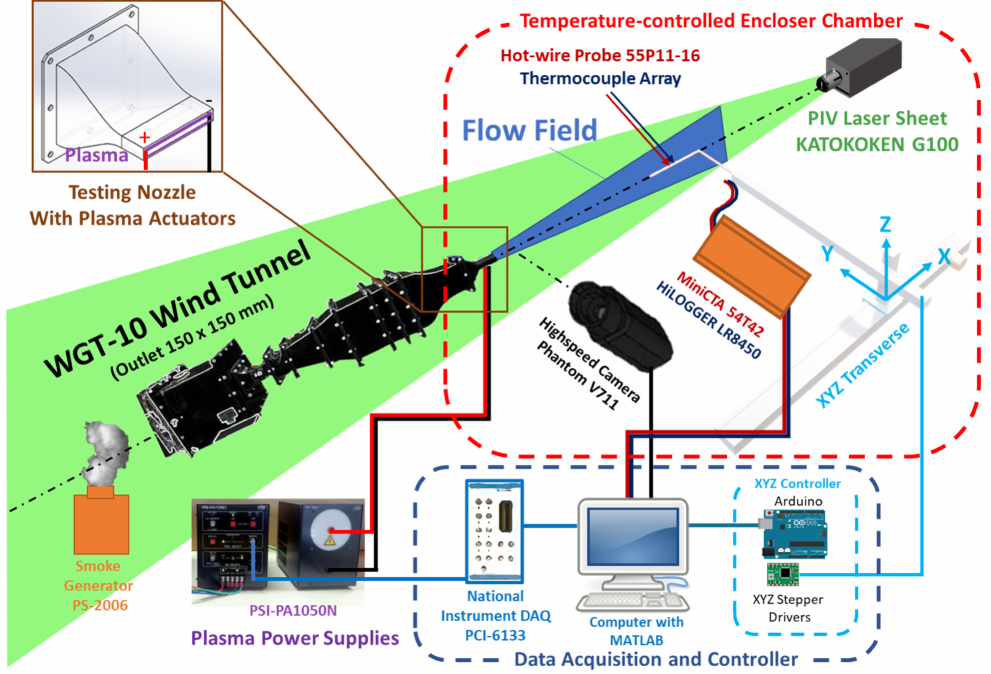
Figure 2. Overview of the experiment